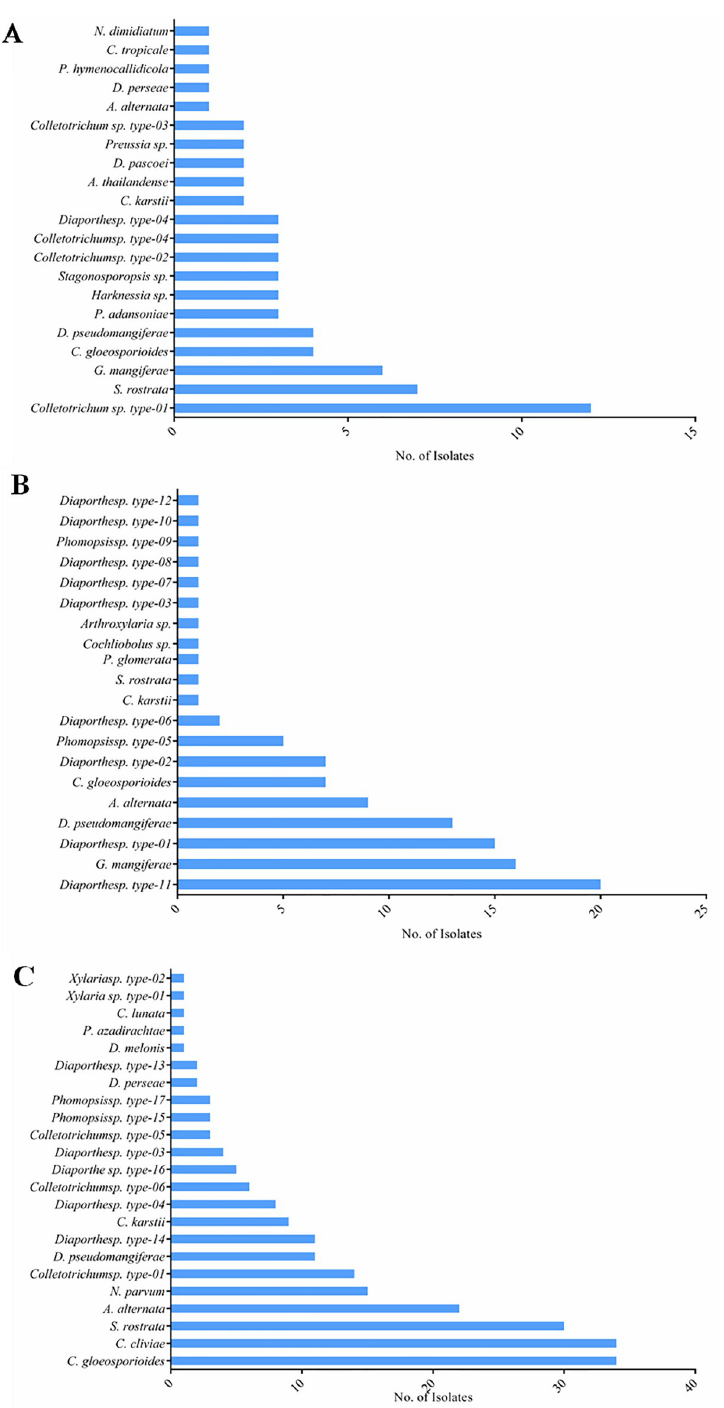
Fig 13. Ranked species graphs of foliar endophytic fungal assemblages in (A) A . elaeagniodea , (B) F . inermis and (C) P . serratifolia